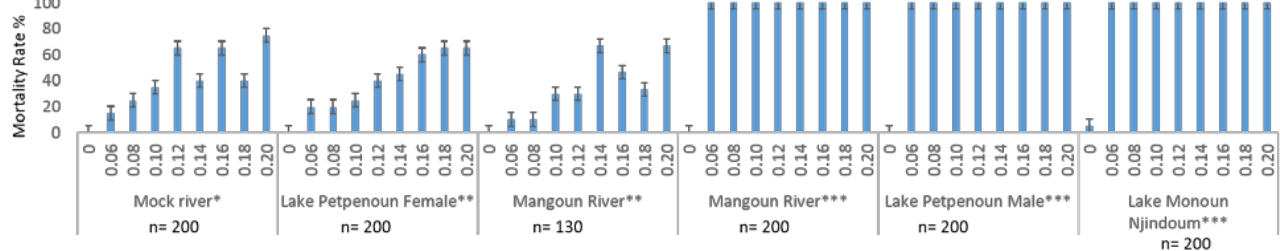
Figure 1. Mortality rates of adults to different Niclosamide (Bayluscide WP 70) doses according to snail species. Figures on the x axis represent the different concentrations of Niclosamide, “0” being used for controls.*: Biomphalaria pfeifferi ; **: Biomphalaria camerunensis ; ***: Bulinus truncatus ; n: number of tested snails.